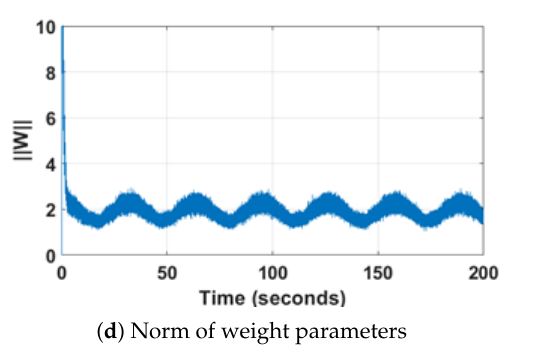
Figure 4. The out responses of the AUV system in the third